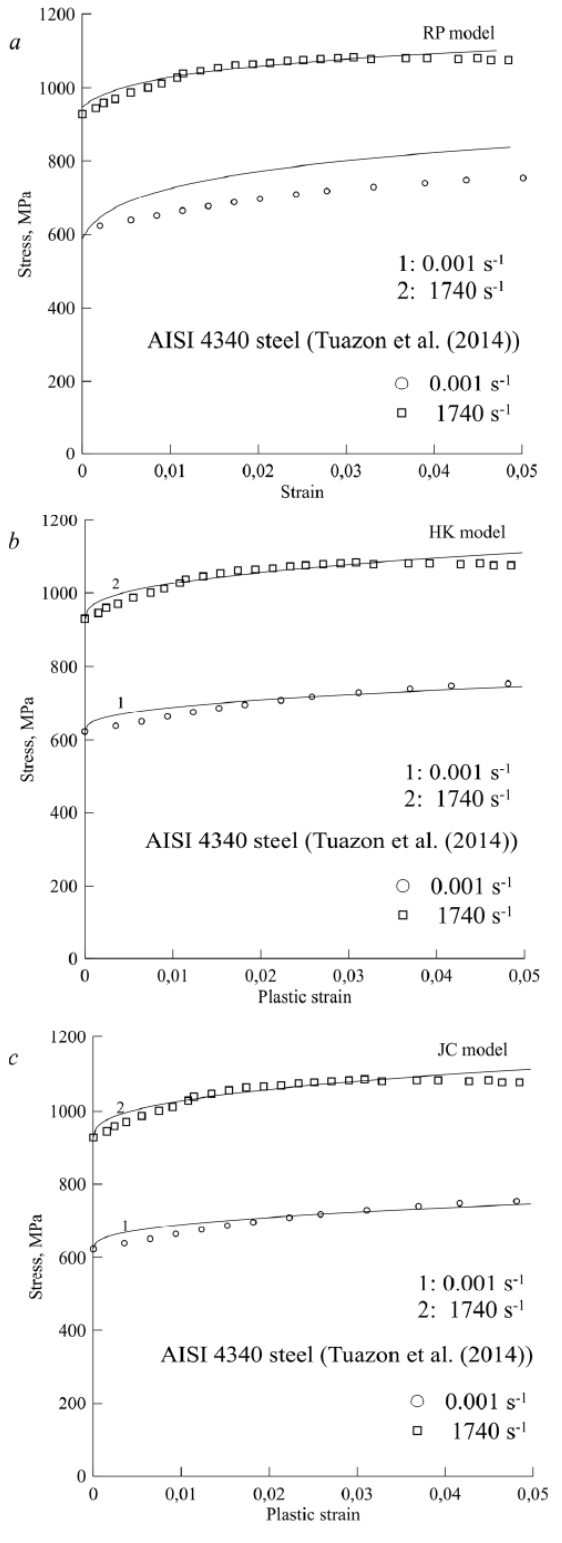
Fig. 8. Stress-strain relationships of AISI4340 steel (data from [57]), plotted by RP model (a), HK model (b) and JC model